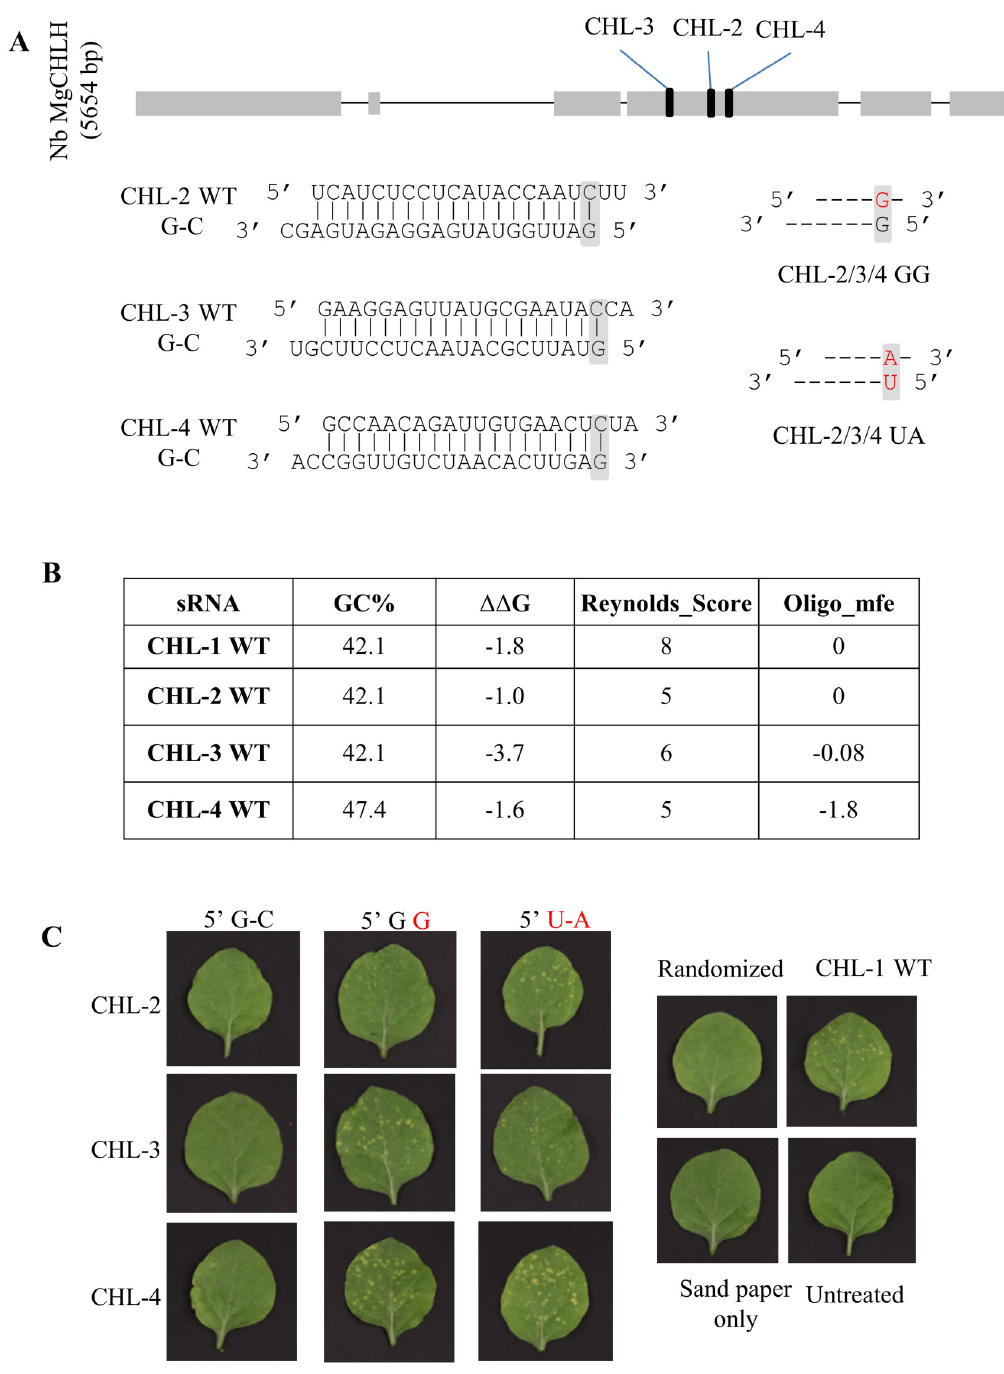
Fig 5. siRNAs containing a 5’ G can be efficacious for gene silencing when the nucleotide on the antisense strand is the non-complementary G or when a U-A pair is substituted. A, Location of three 21nt siRNAs in the CHLH genomic sequence in the N . benthamiana . Boxes and lines indicate the exons and introns, respectively. These siRNAs were synthesized in their native form as a G-C pairing at the 5’ end of AS strand or substituted with a G-G mismatch or U-A pairing. The nucleotides of 1 st position of AS and 19 th position of S strands are shaded in grey. B, Key properties for the siRNAs tested were compared (40, 41). C, siRNA duplexes were applied to N . benthamiana leaves with sandpaper abrasion, and treated leaves were photographed under white light 4